Question: Provide a publication-style caption for this figure.
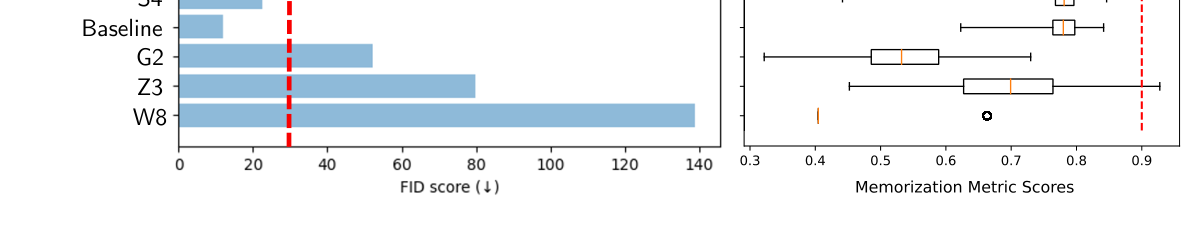
Answer: FID and memorization metric scores for the submissions alongside the FID and memorization metric scores of a baseline StyleGAN2 model trained in-house